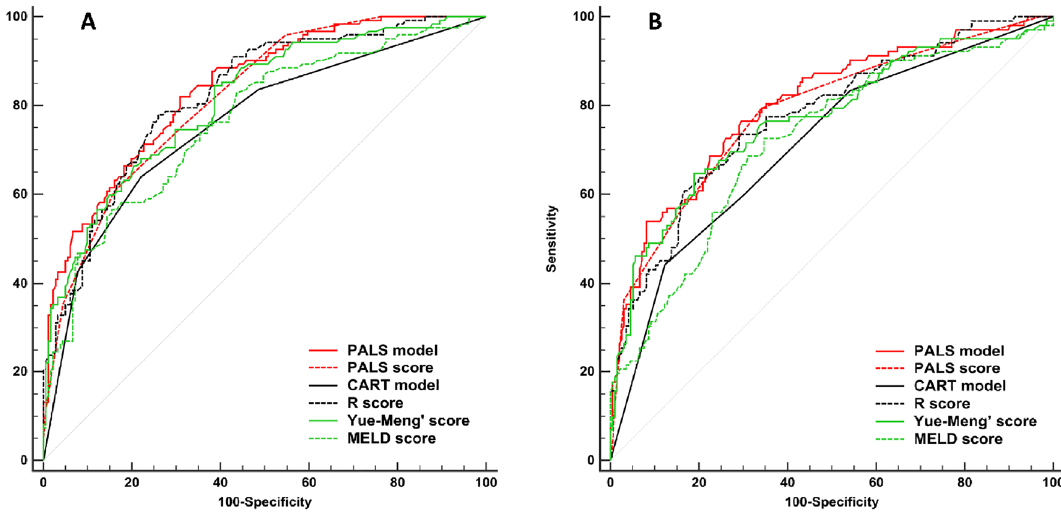
Figure 3. Receiver operating curves (ROC) for the abilities of risk models to predict 3-month mortality. ROC for risk models predicting 3-month mortality in the derivation cohort ( A ) and validation cohort ( B ). Our PALS model and PALS score were as capable or superior to all other models in predicting 3-month mortality. PALS model predictive model of short-term prognosis for patients treated with artificial liver support system therapy, PALS score predictive score of short-term prognosis for patients treated with artificial liver support system therapy, CART model classification and regression tree model, MELD score score of model for end-stage liver disease.